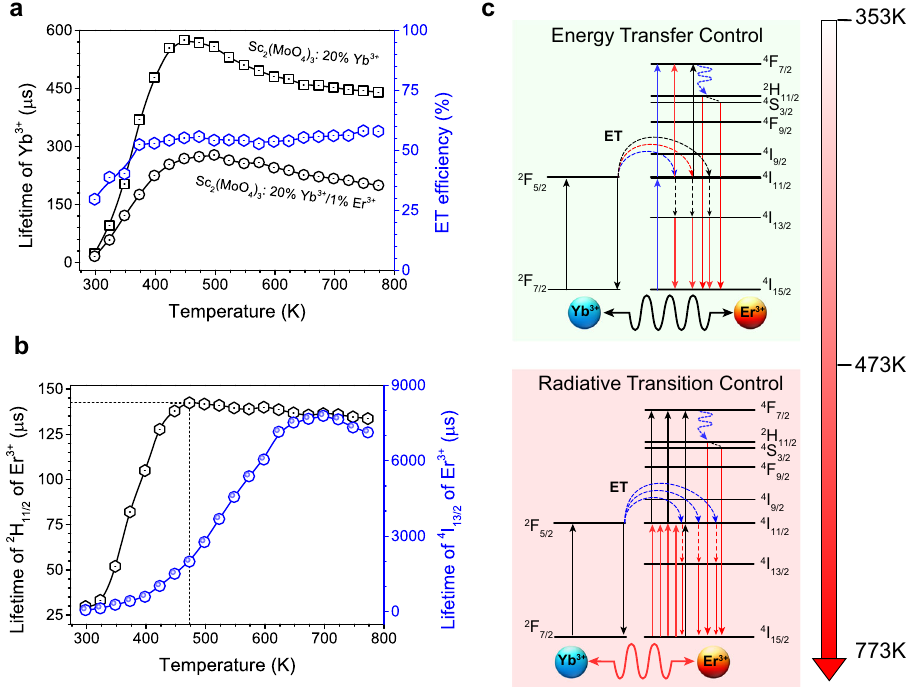
Fig. 5 Thermally enhanced photoluminescence mechanism. a Temperature-dependent luminescence lifetime of 2 F 5/2 excited state of Yb 3 + in Yb 3 + /Er 3 + - co-doped and Yb 3 + -doped Sc 2 (MoO 4 ) 3 , respectively. Temperature-dependent energy transfer ef fi ciency of Yb 3 + -to-Er 3 + . b Temperature-dependent lifetimes of 2 H 11/2 (522 nm) and 4 I 13/2 (1538 nm) excited states of Er 3 + in Sc 2 (MoO 4 ) 3 :20%Yb/1%Er, respectively. c Energy level diagram of green UC and NIR DS emission showing the proposed temperature dependence of electronic transition and energy-transfer processes in Sc 2 (MoO 4 ) 3 :Yb/Er with two- dimensional negative thermal